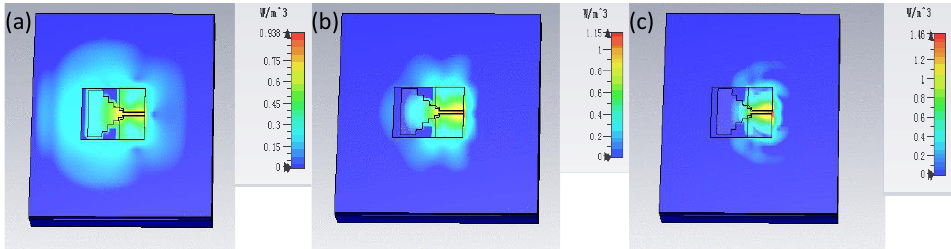
Figure 10. SAR of the proposed antenna distanced by a gap of 3 mm from the human tissue model representing ( a ) 2.42 GHz ( b ) 5.72 GHz ( c ) 9 GHz .